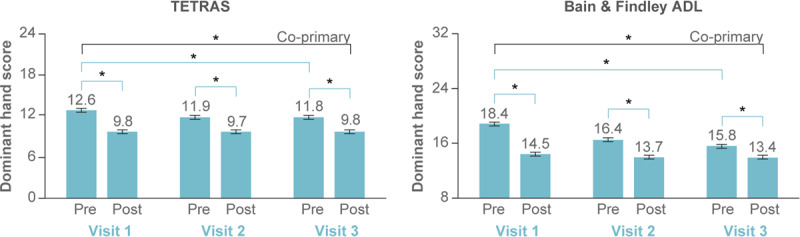
Co-primary endpoints assessed in-clinic showed improvement in TETRAS and BF-ADL. Average TETRAS dominant hand score (left, scale range 0–24) and BF-ADL dominant hand score (right, scale range 8 to 32) are shown pre- and post-stimulation conducted at each in-clinic visit. The co-primary TETRAS and BF-ADL endpoints—improvement from baseline (pre-stimulation rating at Visit 1) to study exit (post-stimulation rating at Visit 3)—were both met (n = 205). Therapeutic response was also significant within each visit for both TETRAS and BF-ADL, and the pre-stimulation tremor rating improved significantly over 3 months of use. Error bars represent ±1 SEM, and * indicates p < 0.0001.